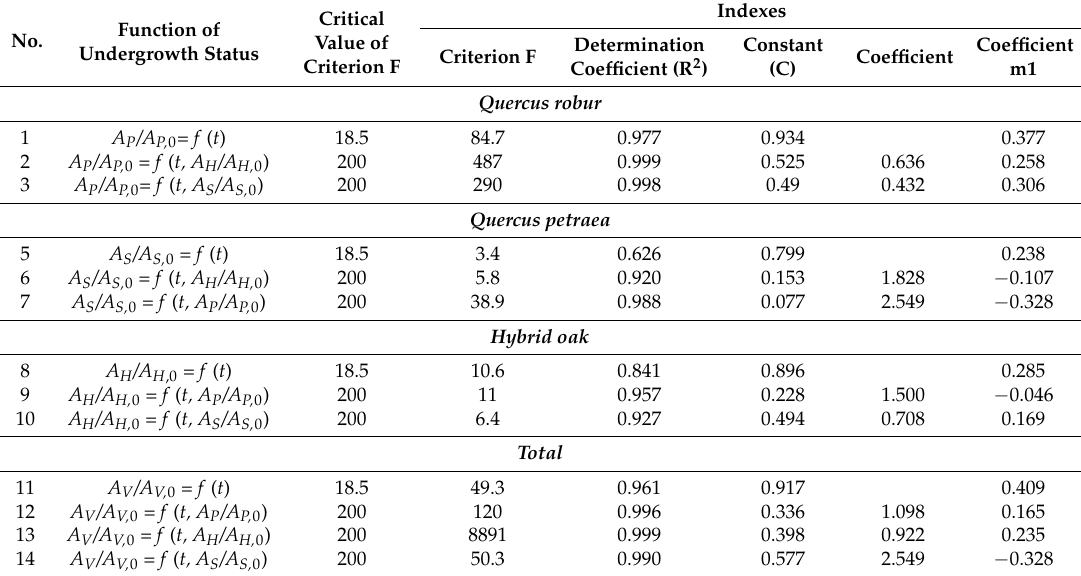
Table 5. The relative density of the development of oak trees in the undergrowth, with group regression analysis (Equation